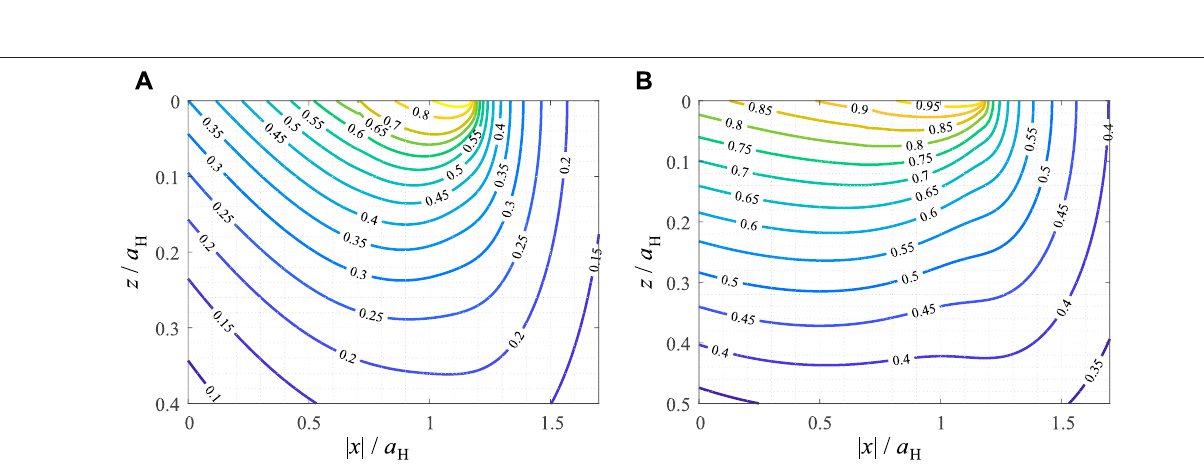
Frontiers in Mechanical Engineering | www.frontiersin.org May 2022 | Volume 8 | Article 904282